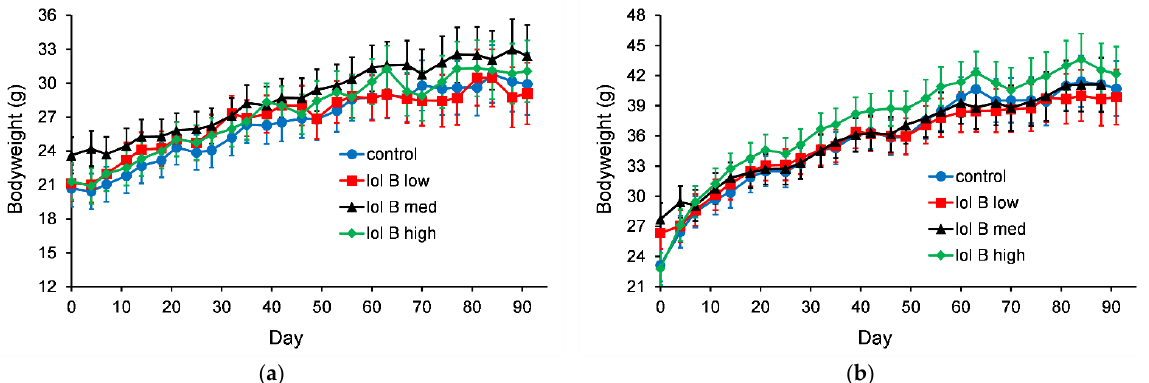
Figure 1. Bodyweight of female mice ( a ) or male mice ( b ) fed diet containing lolitrem B (0, 0.265, 0.53 or 1.06 ppm for control, low, med and high, respectively). The error bars are the standard error obtained from the fitted model.